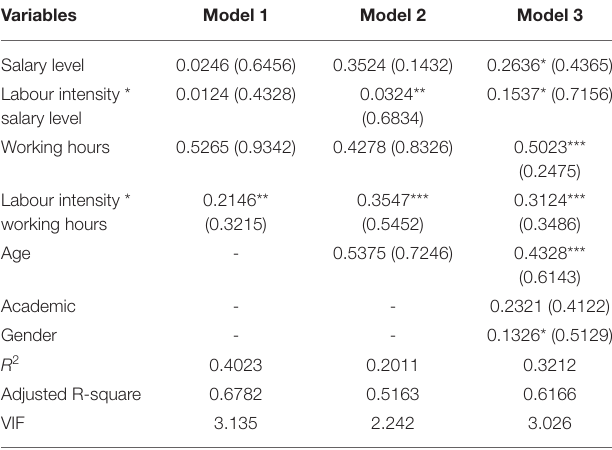
TABLE 4 | Estimation results of moderating